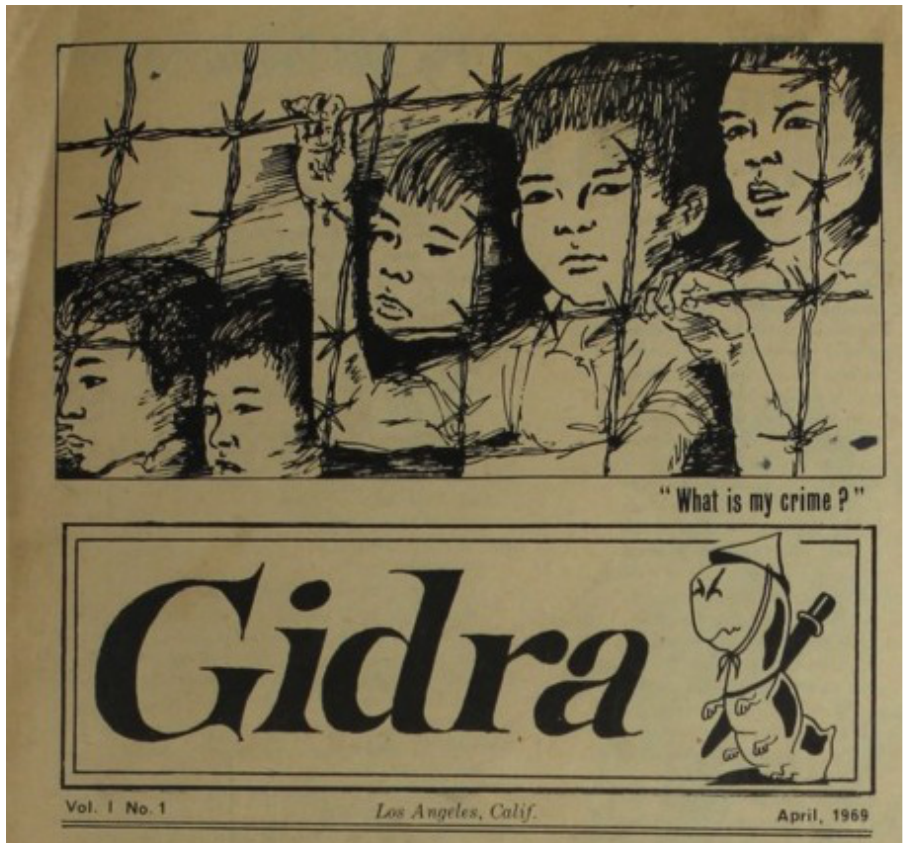
FIGURE 1. GRAPHIC FROM THE COVER OF THE FIRST ISSUE OF GIDRA ALL ILLUSTRATIONS PROVIDED BY